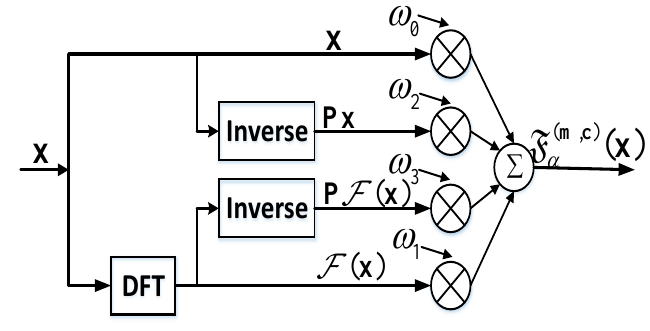
Figure 1. The implementation of the